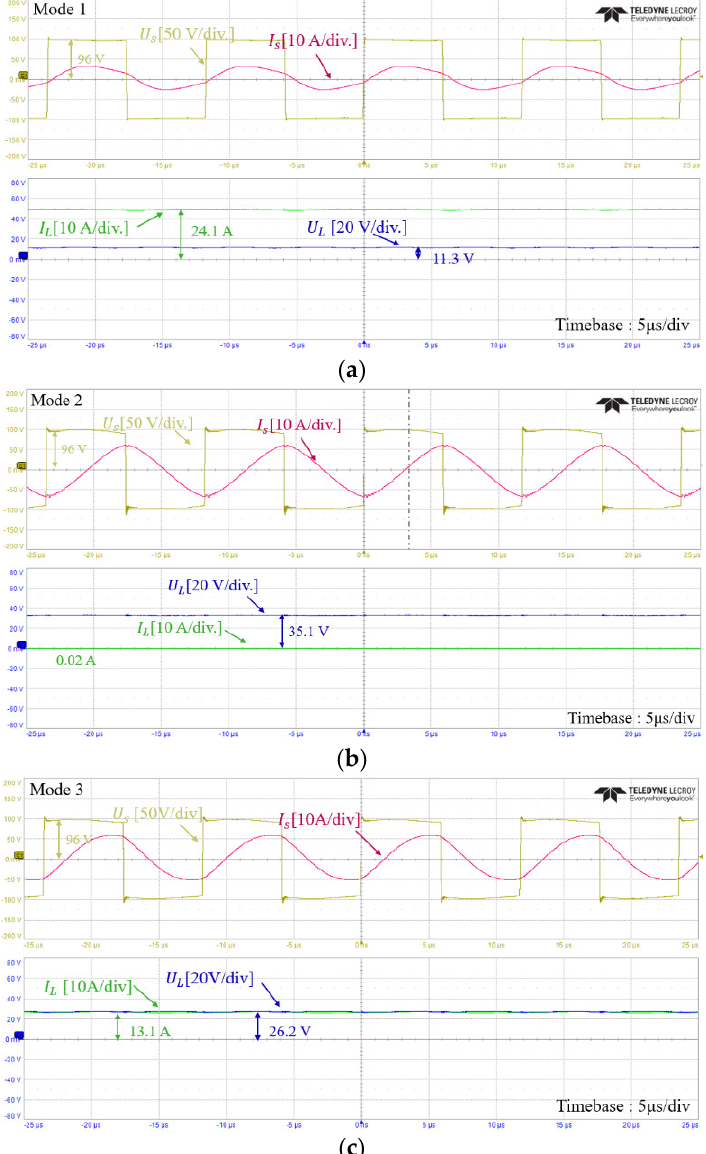
Figure 9. Experimental waveforms of the proposed topology: ( a ) Mode 1: short − circuit load; ( b ) Mode 2: open − circuit load; ( c ) Mode 3: charging region.